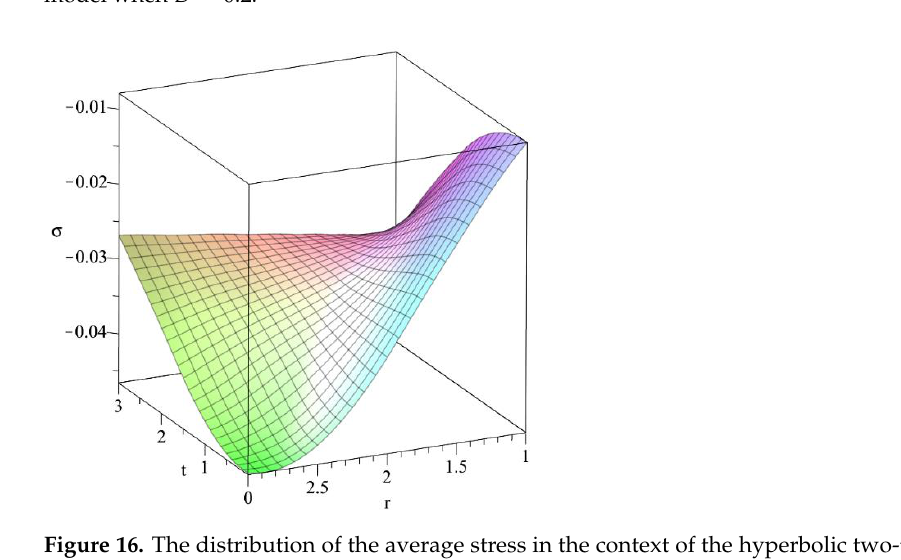
Figure 16. The distribution of the average stress in the context of the hyperbolic two-temperature model when 0.2 D = .